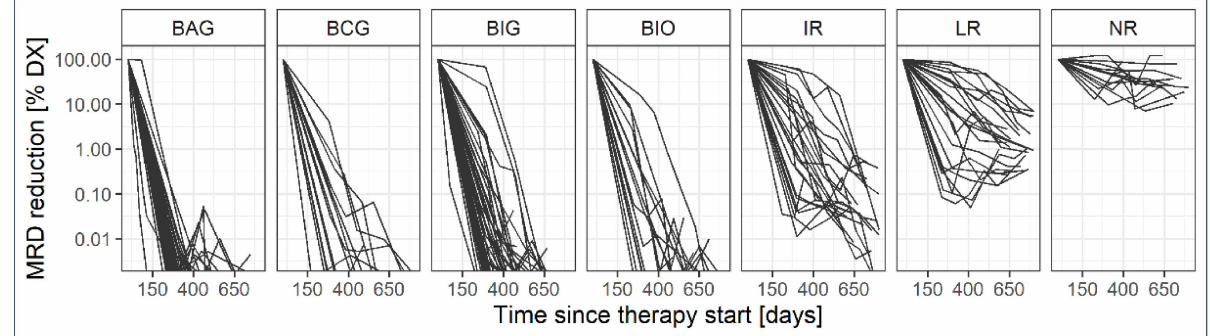
Figure 1. Distribution of patients of the CLL2-BXX trials among the defined MRD response